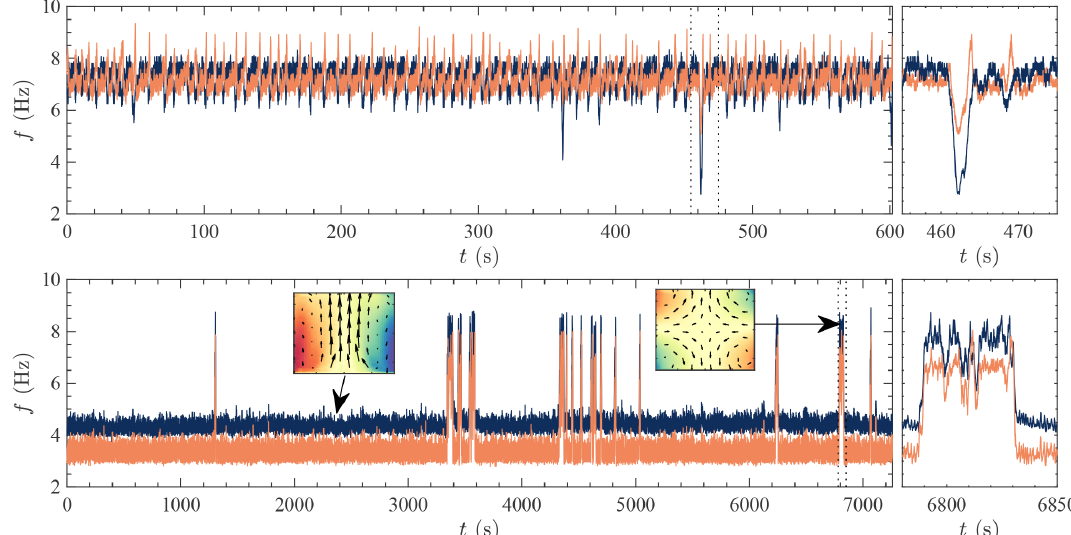
Figure 6. Spontaneous jumps between two circulation configurations observed by measuring the impeller rotation rates for different, fixed, values of the torque imbalance γ . (a) Quasi-periodic, intermittent case, observed for small γ . (b) Rare events case, observed for a larger value of γ . The sudden transitions in the rotation frequencies are signatures of changes in the circulation shape. Note the different timescales (figures adapted from the PhD thesis of Saint-Michel, 2013).